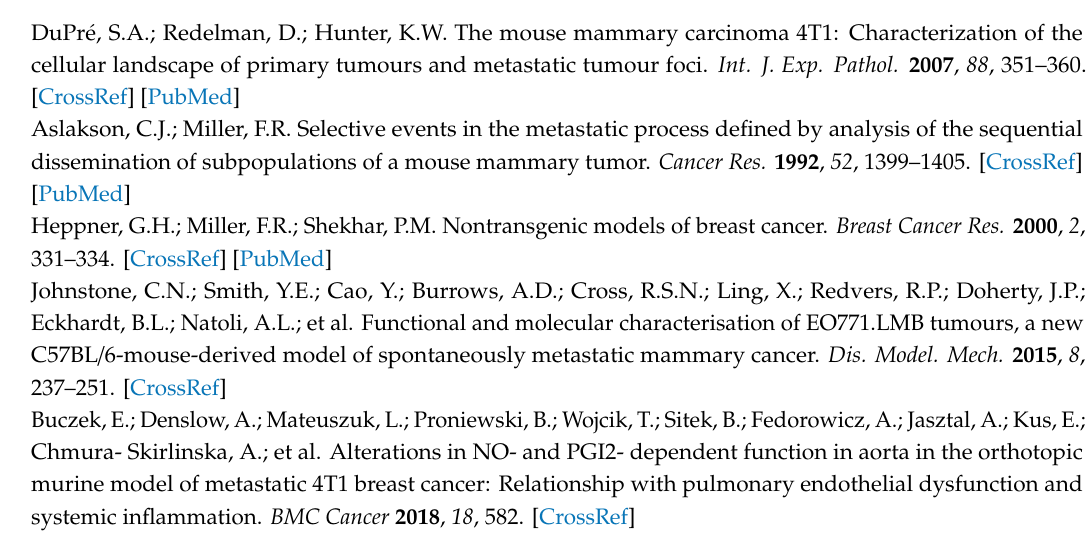
Figure S1. Selected blood morphological parameters of mice bearing 67NR and 4T1 tumors. Figure S2. The level of TTR protein in plasma and various tissues from mice bearing nonmetastatic 67NR and metastatic 4T1 mammary gland cancer cells (young mice). Figure S3. Patients plasma and tumor tissue levels. Figure S4. Kinetics of plasma level of RBP4 and in vitro kinetics of endothelial cells activation after incubation with RBP4. Figure S5. The e ff ect of RBP4 overexpression on kinetics of 67NR / RBP4 and 4T1 / RBP4 tumor growth as well as the level of RBP4 in mammary gland and abdominal adipose tissue. Figure S6. The e ff ect of RBP4 overexpression on angiogenesis of 67NR and 4T1 tumors. Figure S7. Expression of surface molecules after 24 h in vitro incubation of 67NR and 4T1 cells with RBP4 protein at a concentration of 200 ng / mL. Figure S8. STAT3 phosphorylation and VEGF